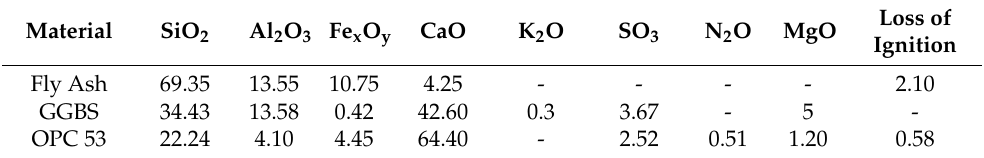
Table 1. Chemical properties of mineral admixtures.